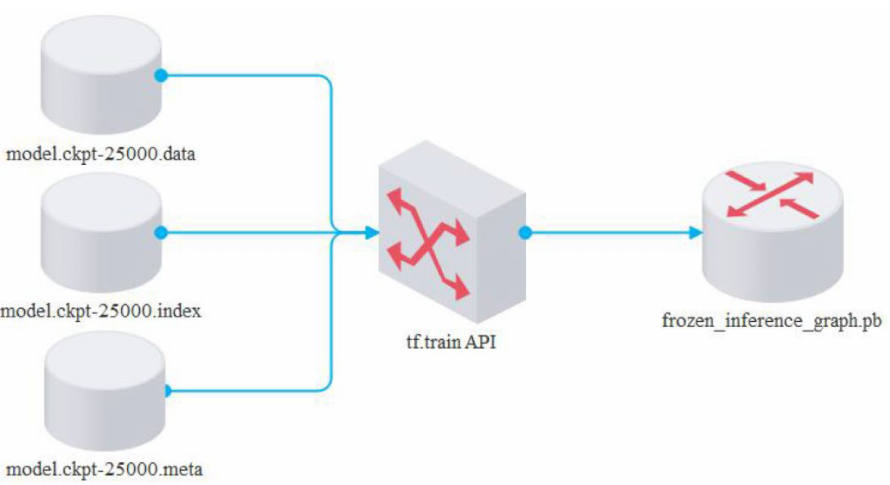
Figure 7. Combination of model structure, key, and value of